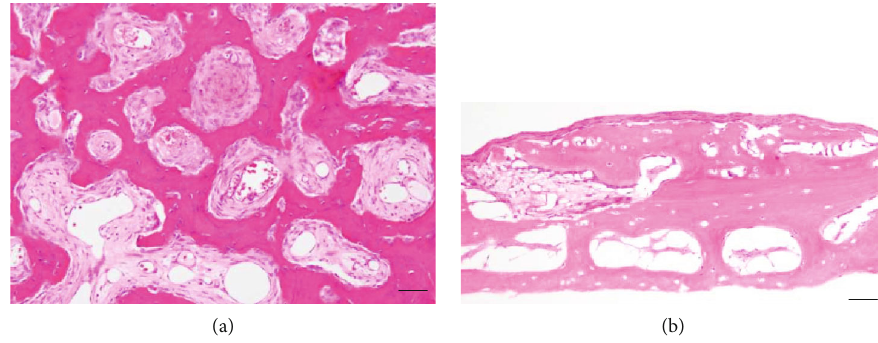
Figure 5: Histopathological fi ndings (original magni fi cation, × 100). (a) Specimens of the high-density lesions comprised irregular piece of fi brous connective tissue adjacent to the woven bone trabecula, which had an osteoid rim-like border and prominent osteoblasts. Bar: 100 μ m. (b) Specimens of the bilateral mandibular low-density lesions exhibited remnants of a partial bony cavity lined by slightly compressed connective tissue. Bar: 100 μ